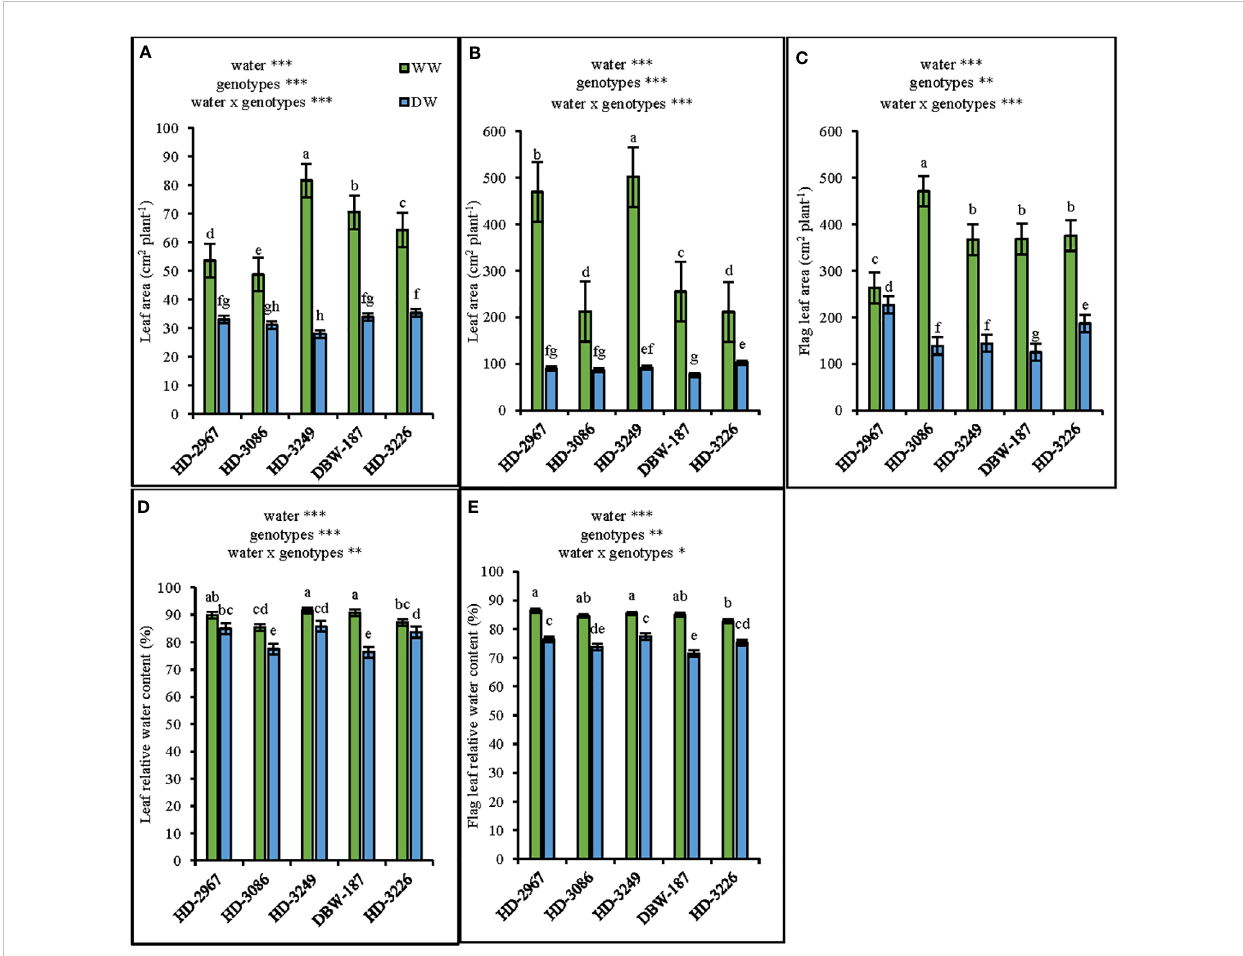
FIGURE 4 Leaf area and leaf relative water content of fi ve wheat genotypes under well- (WW) and de fi cit-(DW) watered conditions. (A) : leaf area at 45 days (Z25) (B) : leaf area at fl owering (Z61), (C) : fl ag leaf area at fl owering (Z61), (D) : leaf relative water content at fl owering (Z61), and (E) : fl ag leaf relative water content at fl owering (Z61). Letters above the bars indicates signi fi cant difference among genotypes at p<0.05 (Turkey ’ s HSD test). Signi fi cant at *0.05. **0.01, and ***0.001 probability